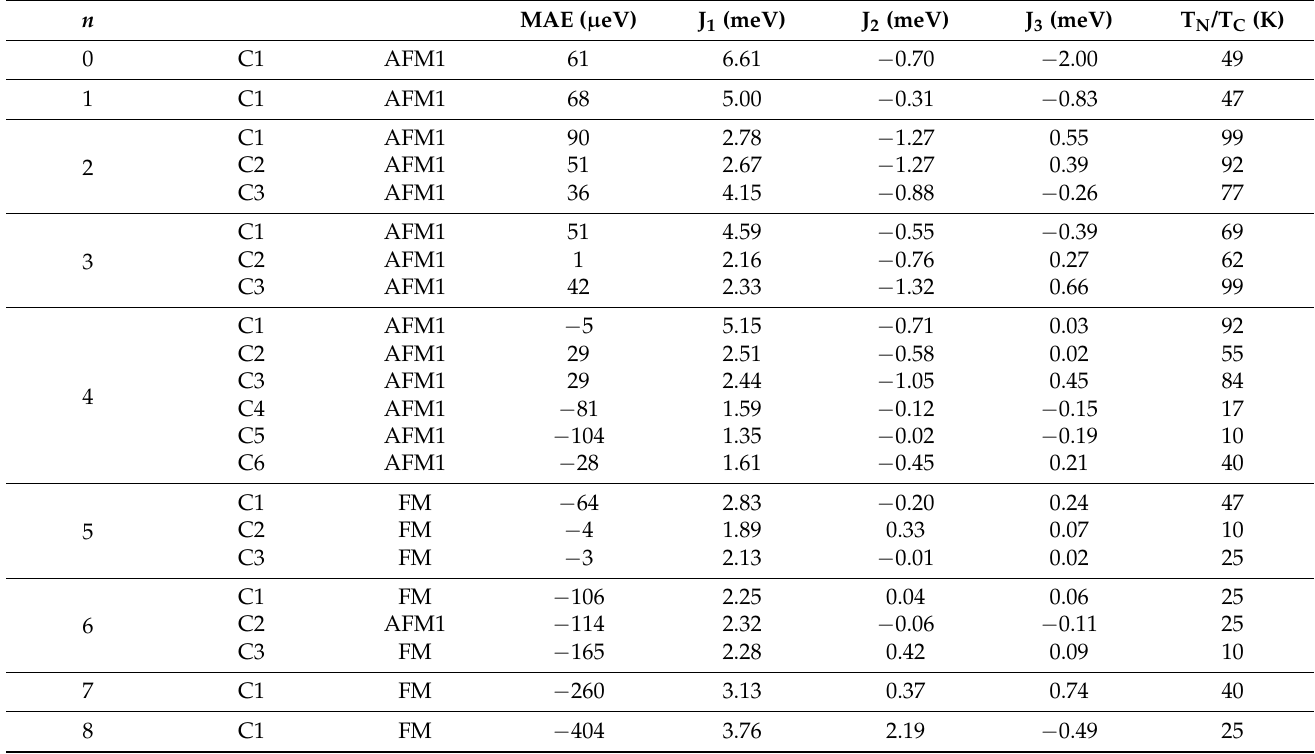
Table 1. J 1 , J 2 , J 3 , MAE, T N , and T C of Cr 2 TiC 2 O n/4 F 2 − n/4